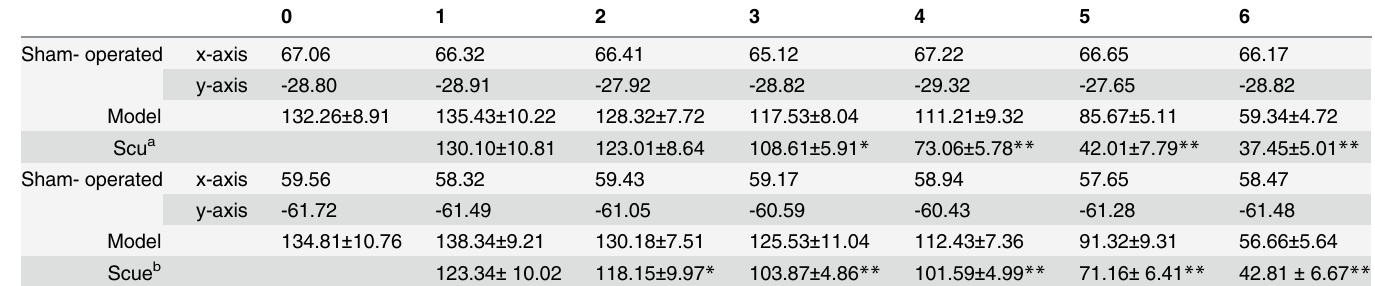
Table legend a scutellarin b scutellarein; compared to the model group * p < 0.05 ** p <